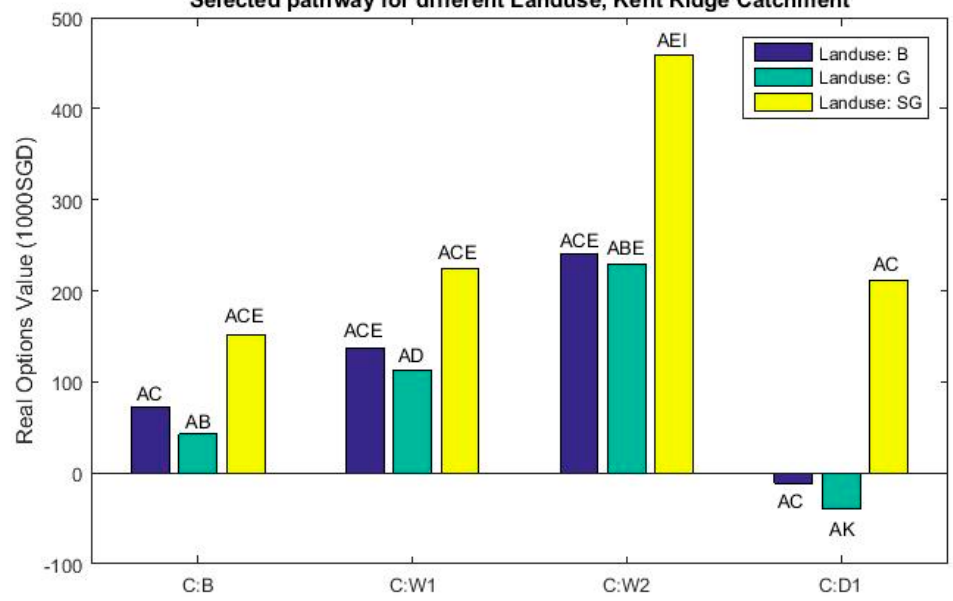
Figure 10. Comparison of the selection criterion (Real Options Analysis) for pathways selected for different climate scenarios (C) and landuse scenarios by the BTT sequencing approach for the Kent Ridge Catchment.